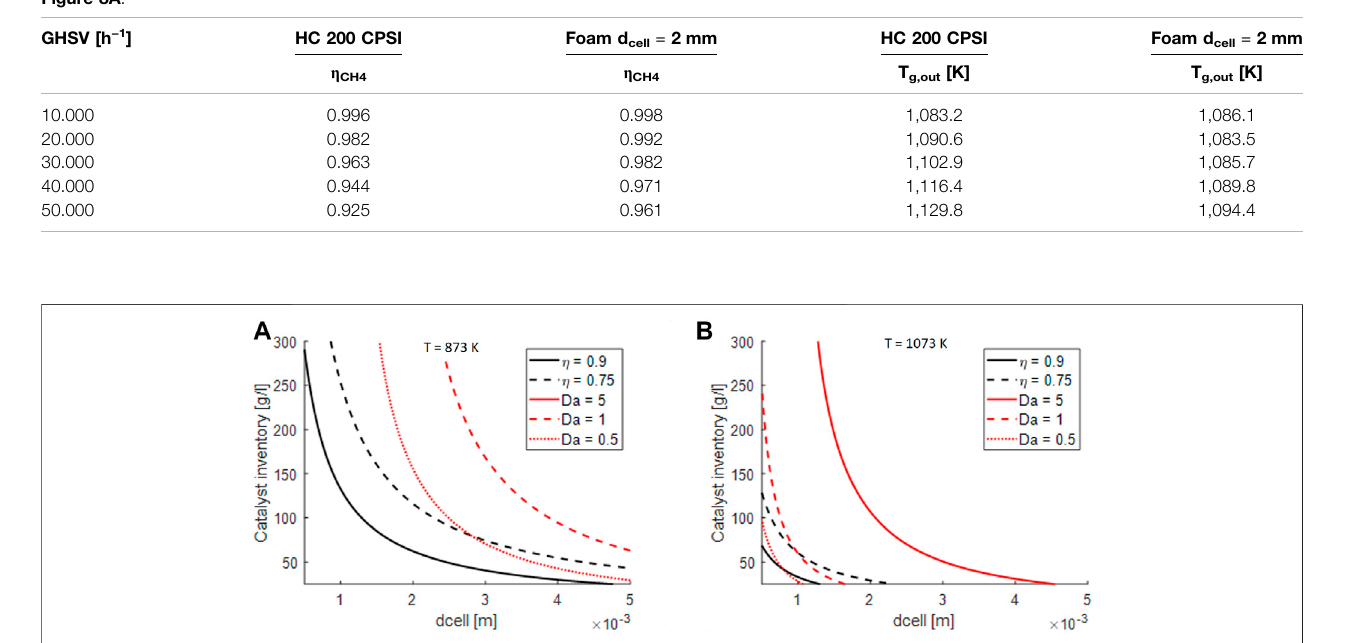
Frontiers in Chemical Engineering |